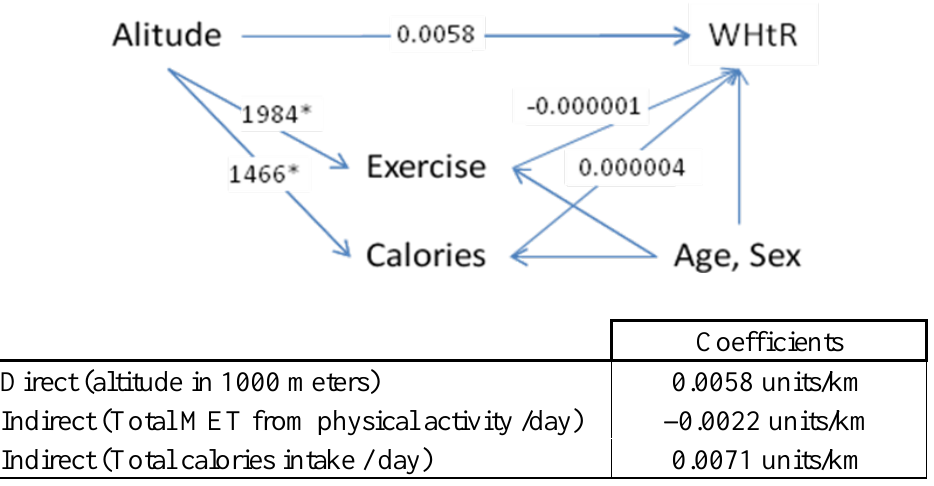
Figure 4. Pathdiagram for the effect of altitude on waist-to-height ratio